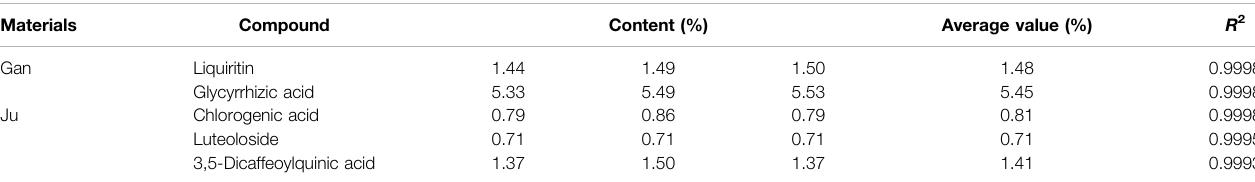
TABLE 5 | compounds content in the extract powder of Gan and